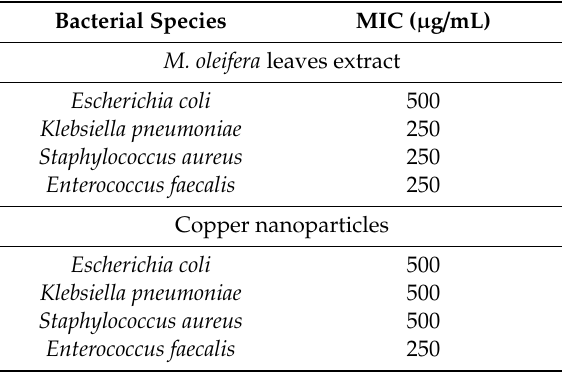
Table 5. Anti-bacterial activity (MIC